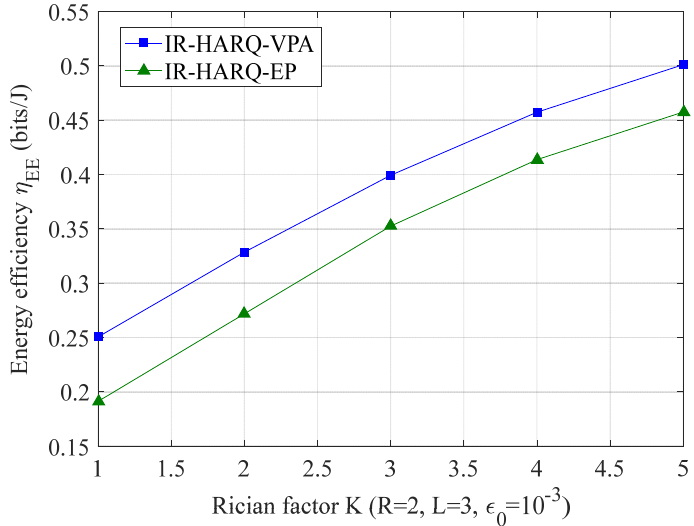
Figure 10. The energy efficiency of IR-HARQ-EP and IR-HARQ-VPA schemes under different Rician factors K .